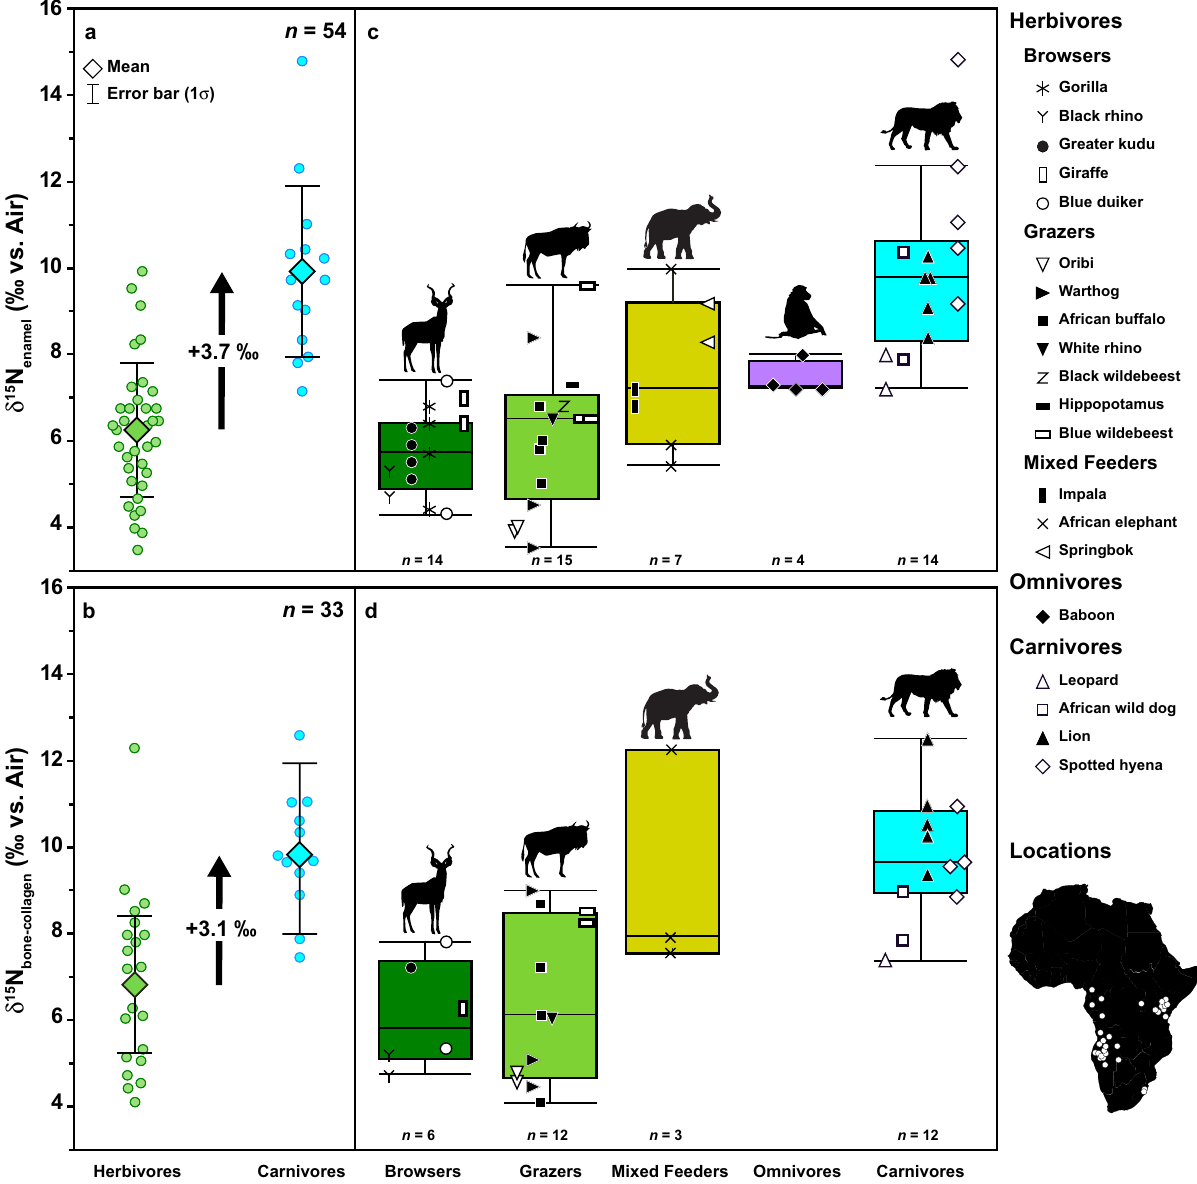
Fig. 1 Nitrogen isotope ratios measured in enamel (top) and bone collagen (bottom). a δ 15 N enamel and b δ 15 N bone-collagen values for all modern African herbivores and carnivores measured in this study, with mean and standard deviation (1 σ ) indicated. The bolded black arrow illustrates the average trophic enrichment between herbivores and carnivores, which is similar in both datasets. Box plots of c δ 15 N enamel and d δ 15 N bone-collagen values for all dietary groups indicating the median and 25 th percentiles. The δ 15 N values for all individuals are plotted by taxon within each dietary group (see Figure